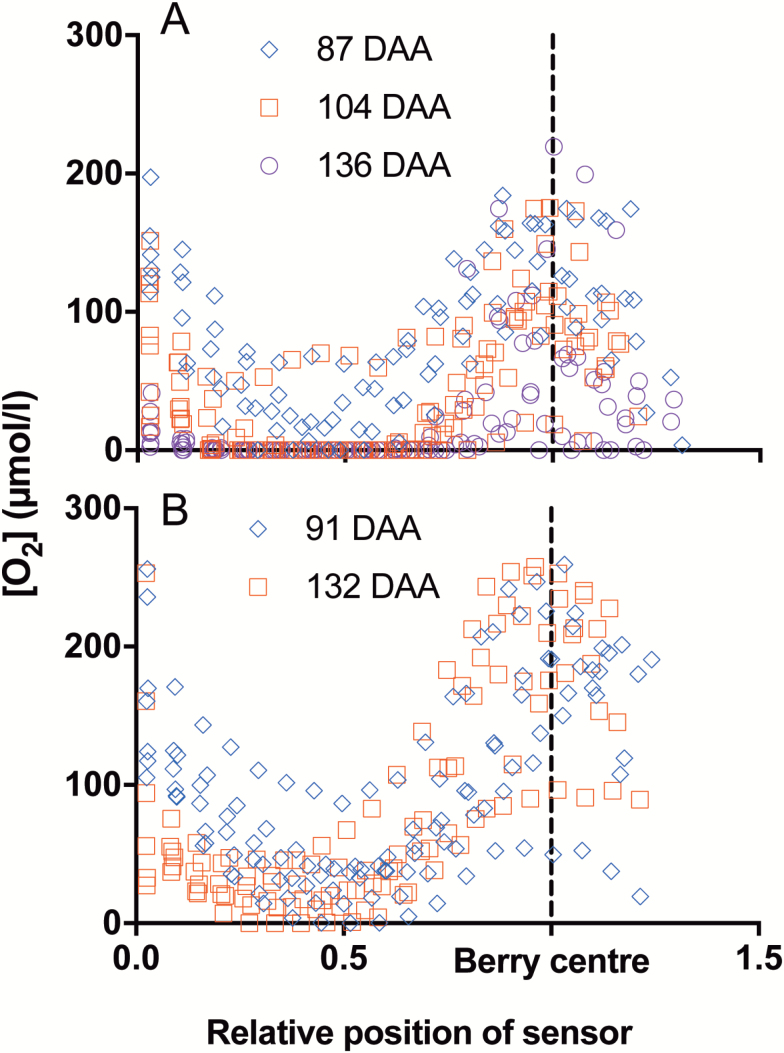
Individual berry [O2] profiles normalized to the berry radii. (A) [O2] profiles of Chardonnay berries sampled at 87, 104, and 136 DAA in the 2015–2016 season (mean data shown in Fig. 2). (B) [O2] profiles of individual Ruby Seedless berries sampled at 91 and 132 DAA in the 2016–2017 season.